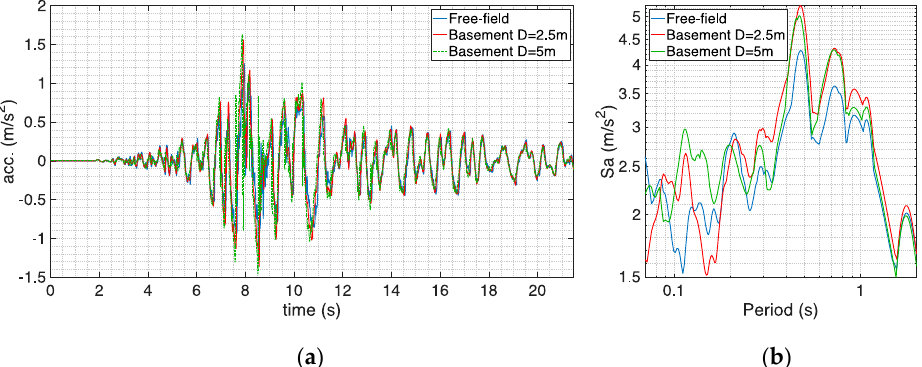
Figure 17. Comparison between surface free-field motion and signals at basement level (two different depths) for BOWW soil profile and record “Accel outcrop” in terms of acceleration ( a ) histories and ( b ) response spectra.